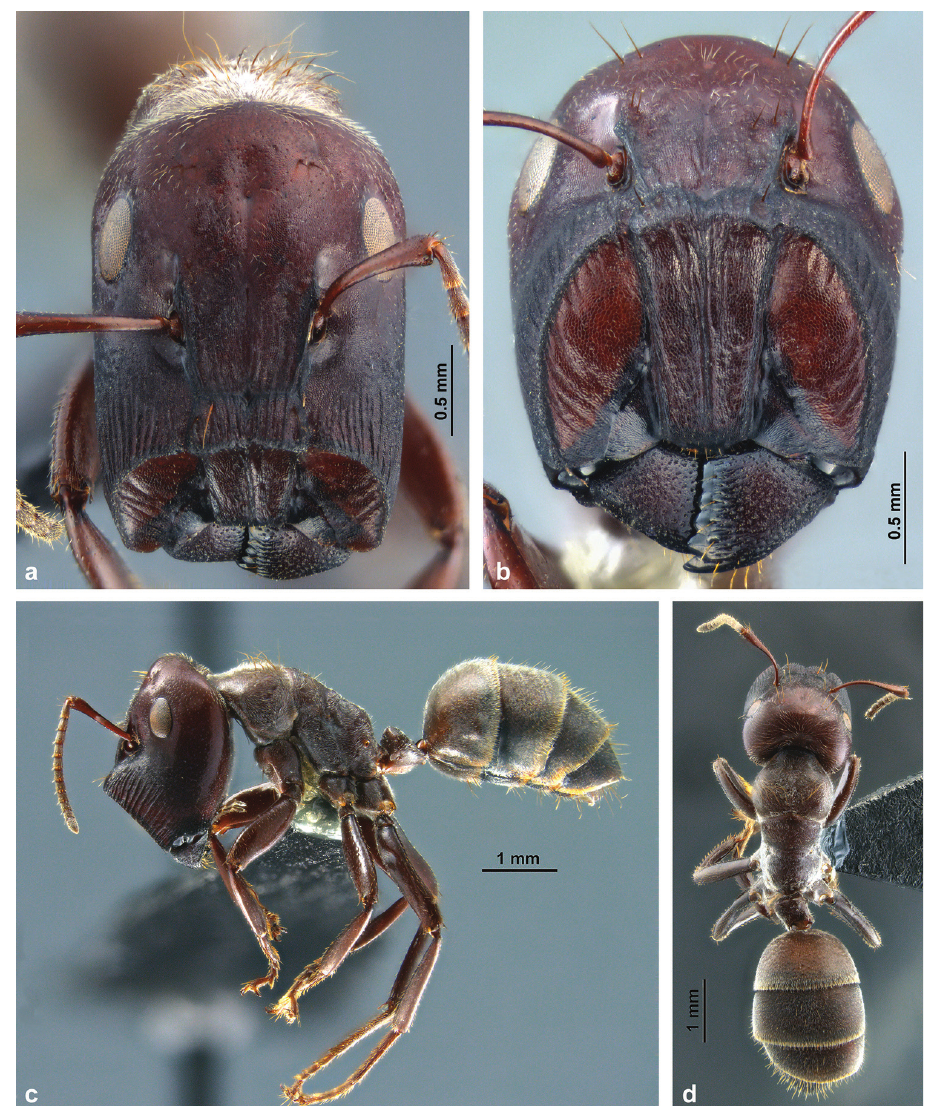
Figure 3. Habitus of C. explodens sp. n., paratype, major worker; a full-face view b frontal shield c lateral, and d dorsal